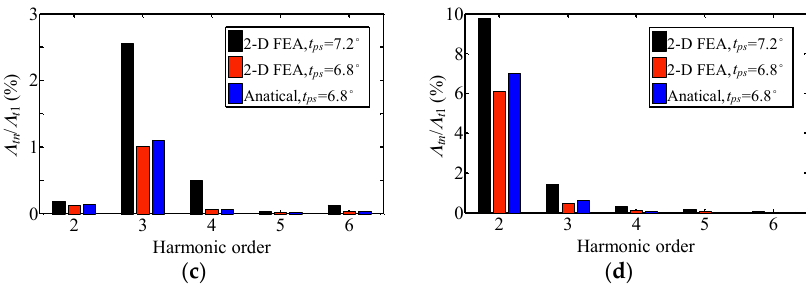
Figure 16. Harmonic analysis of parallel tooth-layer permeances. ( a ) Sub-motor1, B δ = 0.2 T, ∆ θ = π /12 (0.3 ◦ ); ( b ) Sub-motor1, B δ = 2 T, ∆ θ = π /12 (0.3 ◦ ); ( c ) Sub-motor2, B δ = 0.2 T, ∆ θ = π /9 (0.4 ◦ ); ( d ) Sub-motor2, B δ = 2 T, ∆ θ = π /9 (0.4 ◦